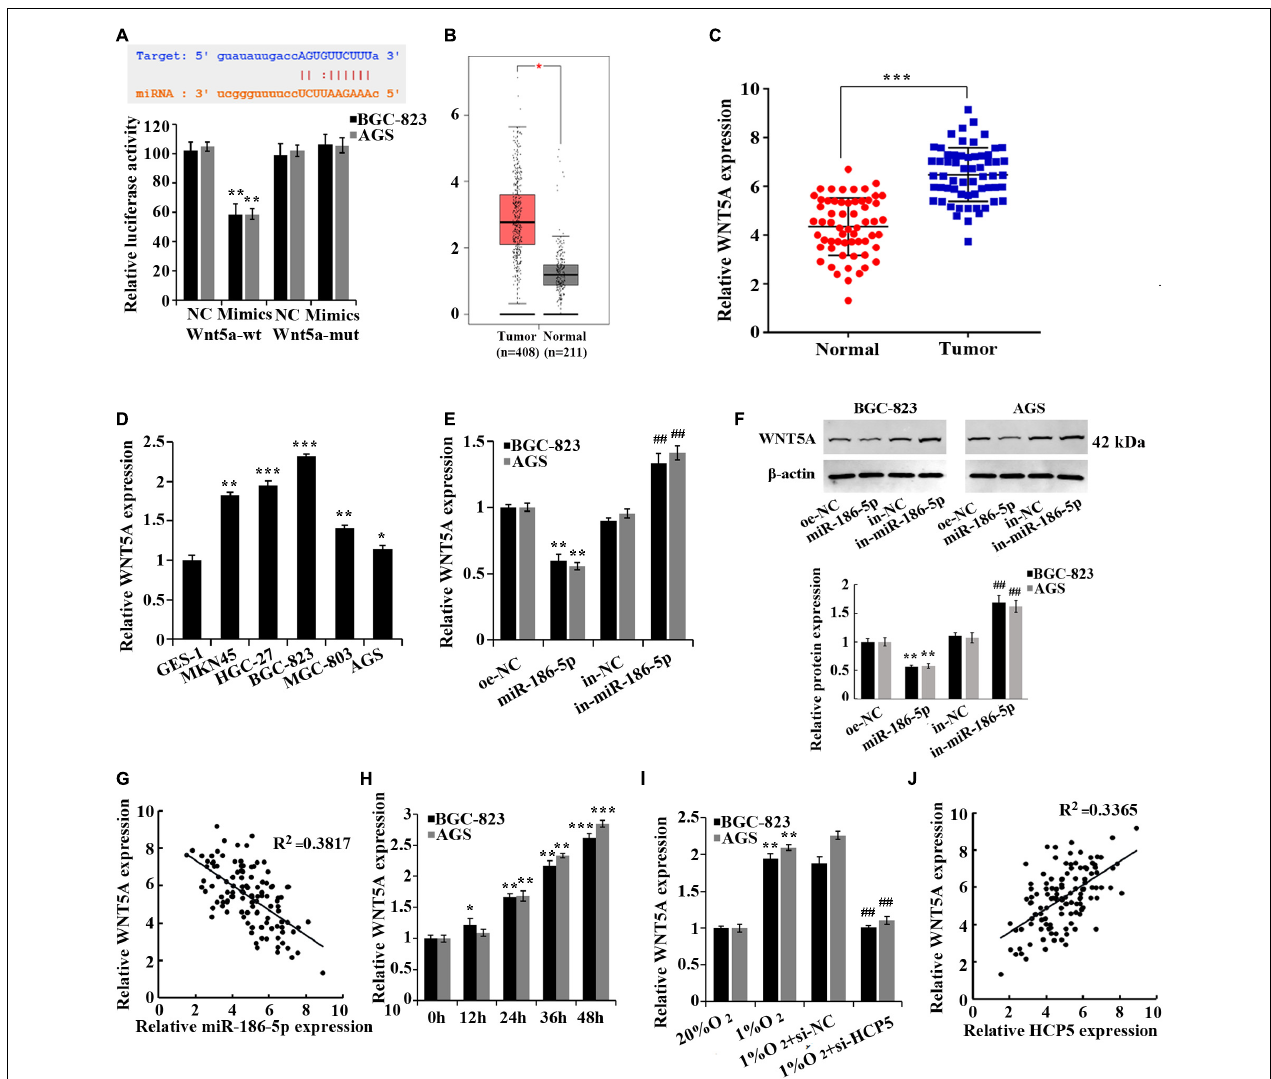
FIGURE 4 | miR-186-5p targets and regulates WNT5A. (A) Dual-luciferase assay for validation of the target relationship between miR-186-5p and WNT5A; ** p < 0.01. (B) WNT5A expression in gastric cancer (GC) tissues and matched normal counterparts shown in the TCGA database. (C) qRT-PCR-based detection of WNT5A expression in GC tissues and matched normal counterparts; *** p < 0.001. (D) qRT-PCR-based detection of HCP5 expression in cells; * p < 0.05, ** p < 0.01, *** p < 0.001 vs. GES-1 cells. (E) qRT-PCR-based detection of WNT5A expression in cells; ** p < 0.01 vs. oe-NC group; ## p < 0.01 vs. in-NC group. (F) Western blotting-based detection of WNT5A protein expression in cells. ** p < 0.01 vs. oe-NC group; ## p < 0.01 vs. in-NC group. (G) Pearson correlation analysis of miR-186-5p and WNT5A expression in GC tissues ( n = 60, R 2 = 0.3817, p < 0.0001). (H) qRT-PCR analysis of WNT5A expression in BGC-823 and AGS cells at different time points of hypoxia; * p < 0.05, ** p < 0.01, *** p < 0.001 vs. 0 h group. (I) qRT-PCR-based detection of WNT5A expression in BGC-823 and AGS cells; ** p < 0.01 vs. 20% O 2 group; ## p < 0.01 vs.1% O 2 + si-NC group. (J) Pearson correlation analysis of HCP5 and WNT5A expression in GC tissues ( n = 60, R 2 = 0.3365, P <